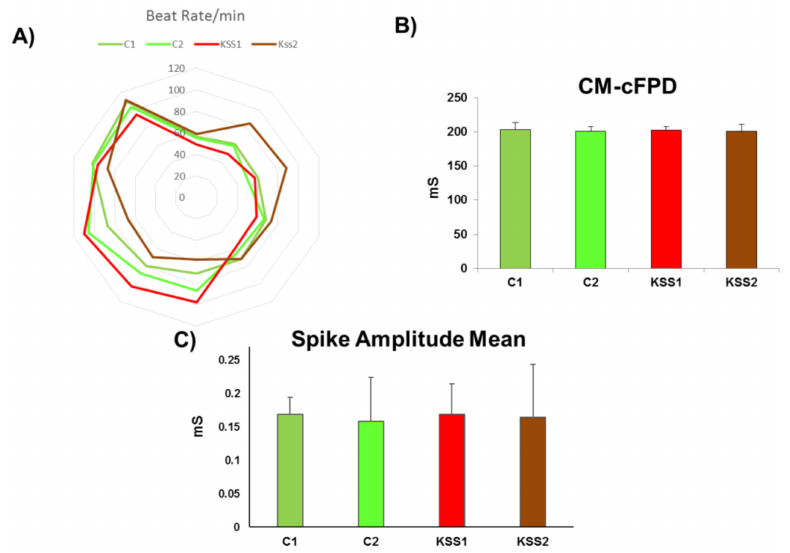
Figure 6. Cardiomyocyte functions were recorded using multi-electrode array. ( A ) The beat rates of the Kearns Sayre syndrome patients (KSS1 and KSS2) induced pluripotent stem cells (iPSC)-derived Cardiomyocytes (CM) did not show any difference from the iPSC derived CM of healthy controls (C1 and C2); ( B ) The corrected field potential of the iPSC derived CM of patients was not different from iPSC derived CM of healthy controls; ( C ) Spike amplitude mean did not differ between the control and KSS iPSC derived CM. n = 3, each experiment was repeated 3–4